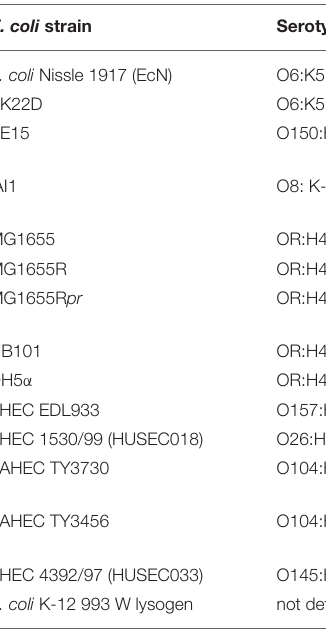
TABLE 1 | E. coli strains used in this